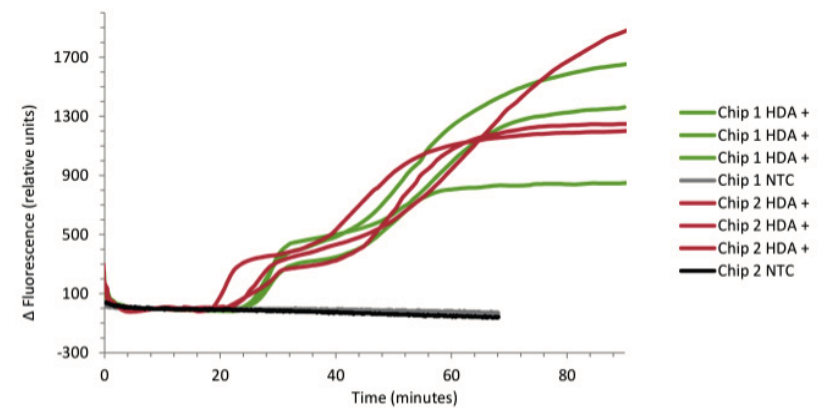
Figure 8. qHDA amplification curves, showing clear differentiation between positive and negative reactions for 1 ng